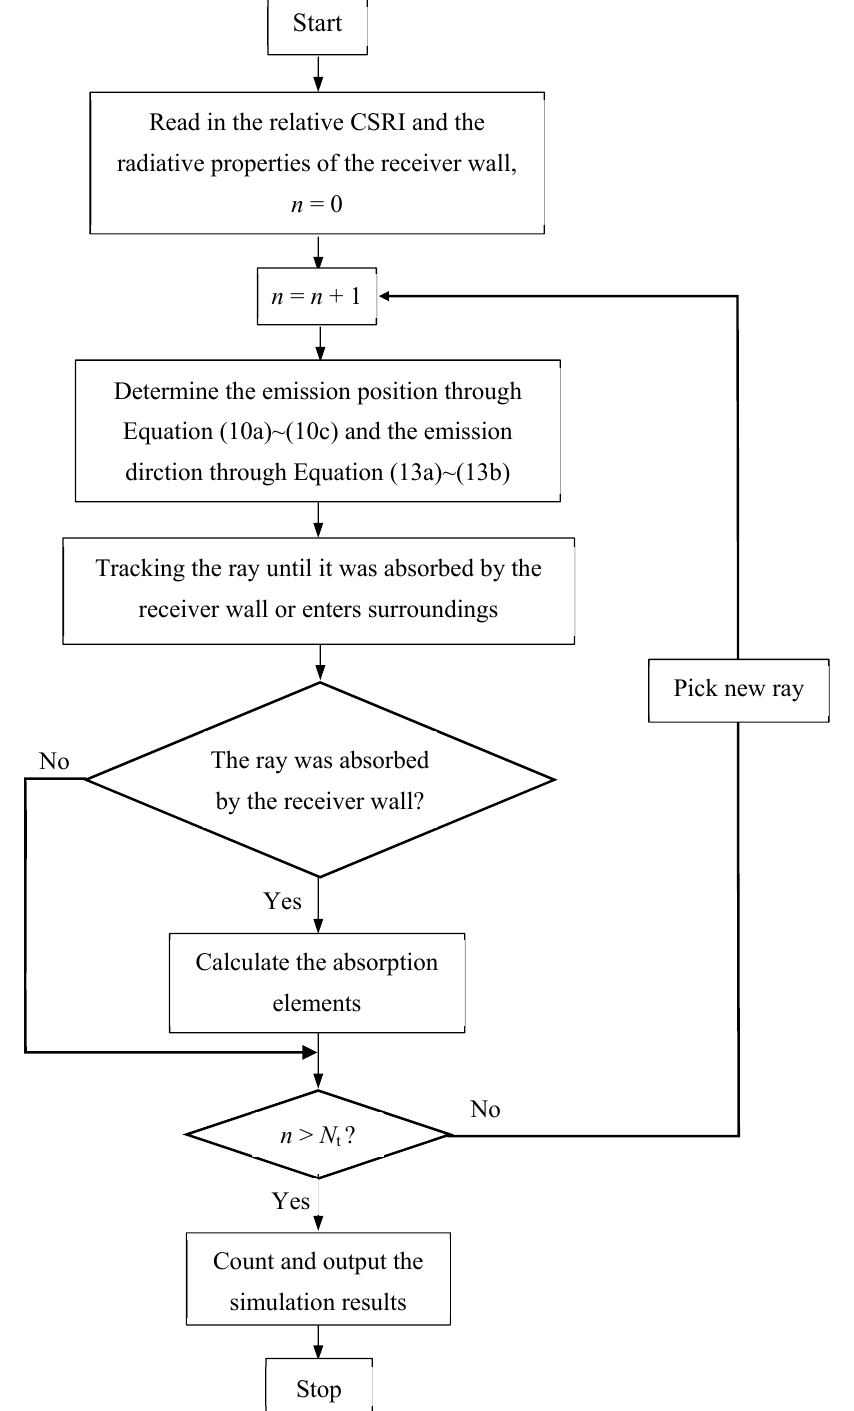
Figure 4. Flowchart of the MCRTM together with the measured results.